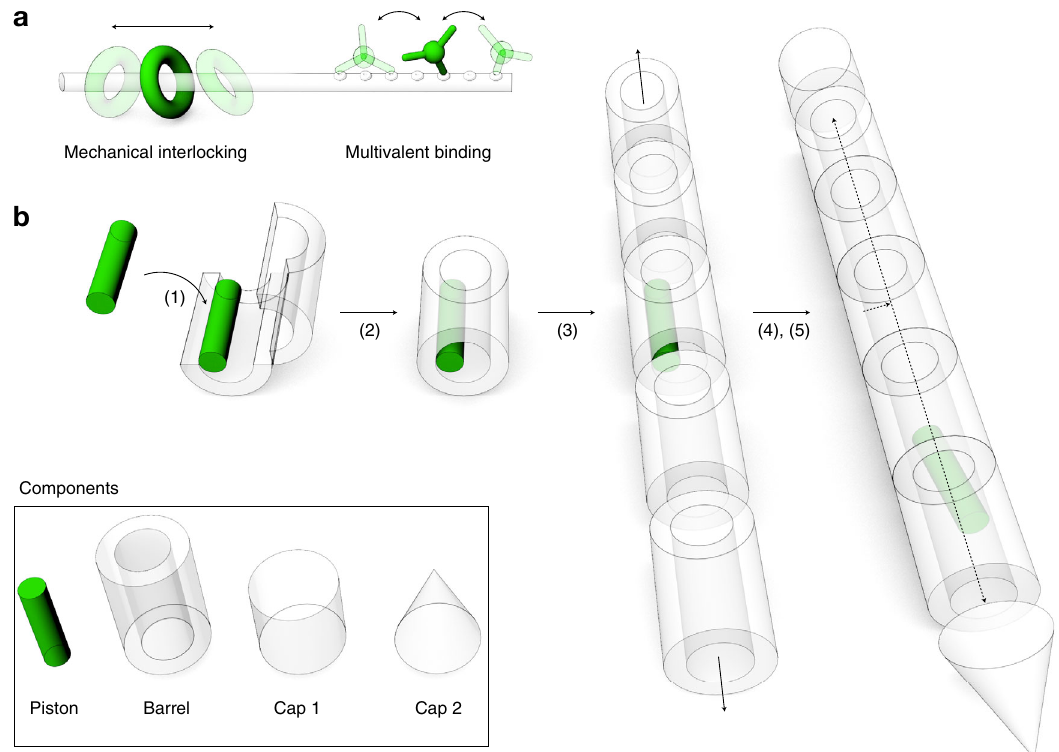
Fig. 1 Concept for constructing a molecular hyperloop. a Strategies for con fi ning a mobile random walker onto a one-dimensional (1D) track. b Schematics of inverted mechanical interlocking and stepwise self-assembly of such a system. 1 loading the “ piston ” building block onto the barrel building block in open state, 2 closure of barrel, 3 polymerization of barrel building blocks into long fi laments, 4 capping of fi laments, 5 release of piston from docking